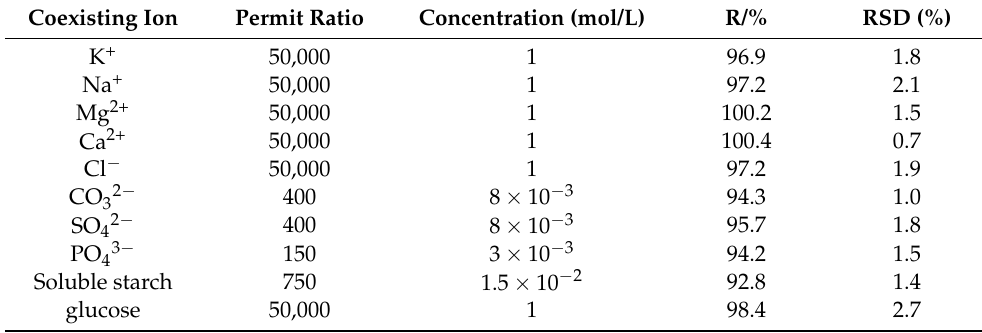
Table 2. The permissible interference ratio of common inorganic ions and organics. Coexisting Ion Permit Ratio Concentration (mol/L) R/% RSD (%) K + 50,000